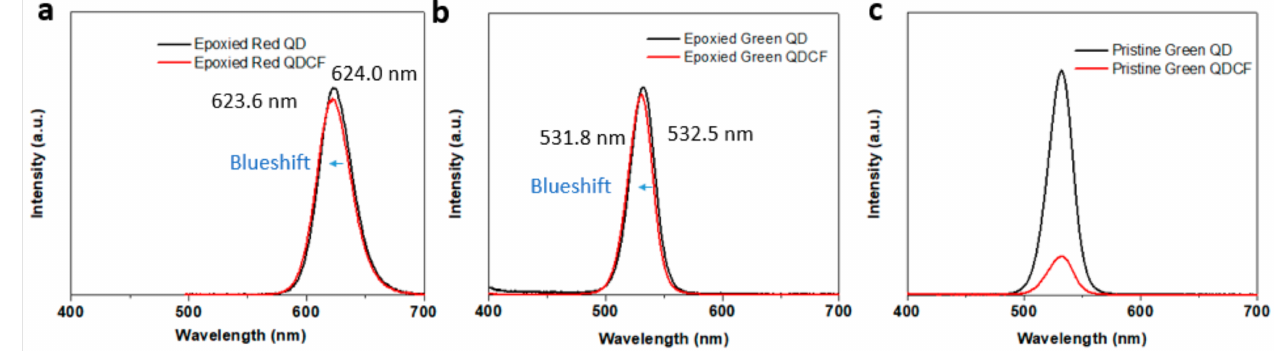
Figure 3. PL spectra ( a ) Epoxied red QD and QDCF; ( b ) Epoxied green QD and QDCF; ( c ) Pristine green QD and QDCF. The wavelength of the excitation light source is 450 nm.